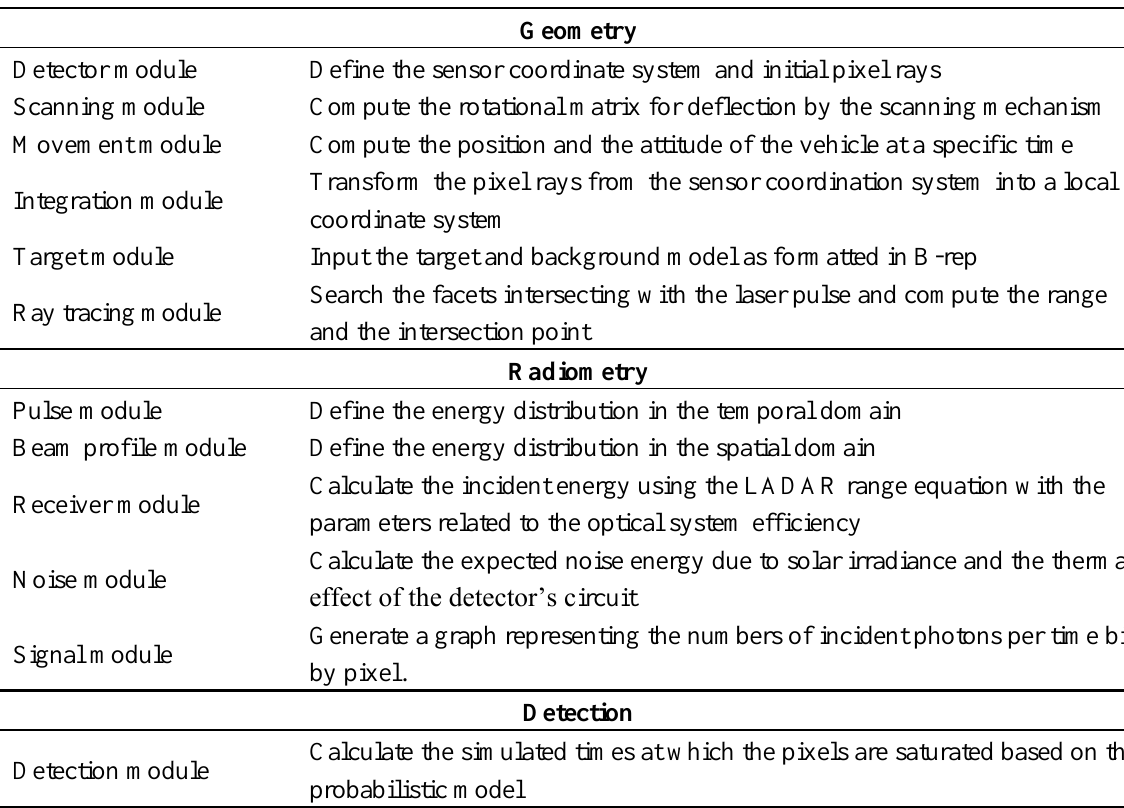
Table 1. Descriptions of the simulator